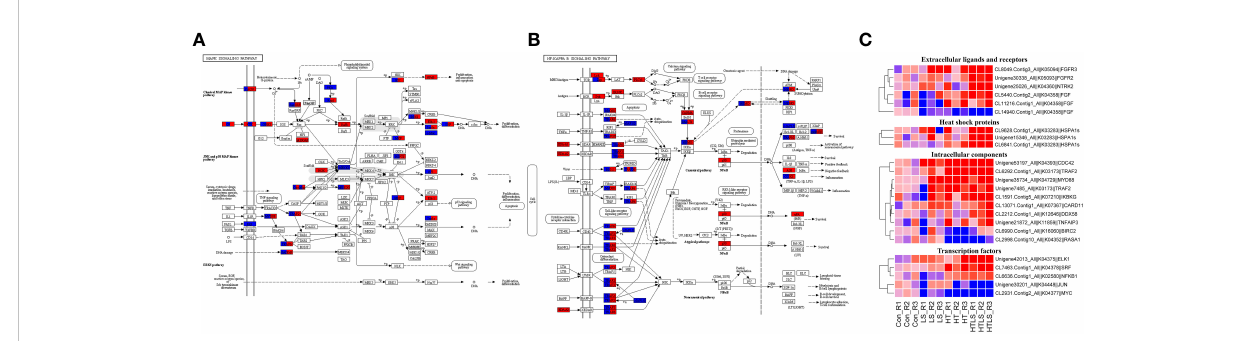
FIGURE 5 Differential expression of components involved in MAPK and NF- k B signaling pathways in HT and HTLS treatments. The KEGG map of DEGs mapped to KEGG (A) “ MAPK signaling pathway ” and (B) “ NF kappa B signaling pathway ” are shown. DEGs detected in HT and HTLS treatment are highlighted in blue and red respectively. The heatmap in (C) provides the expression patterns of DEGs mapped to MAPK and NF- k B signaling pathways in each replicate of each treatment. Note that the expression patterns of DEGs annotated as the molecular chaperone protein HSP70, which is also a component of MAPK pathway, are also shown in the